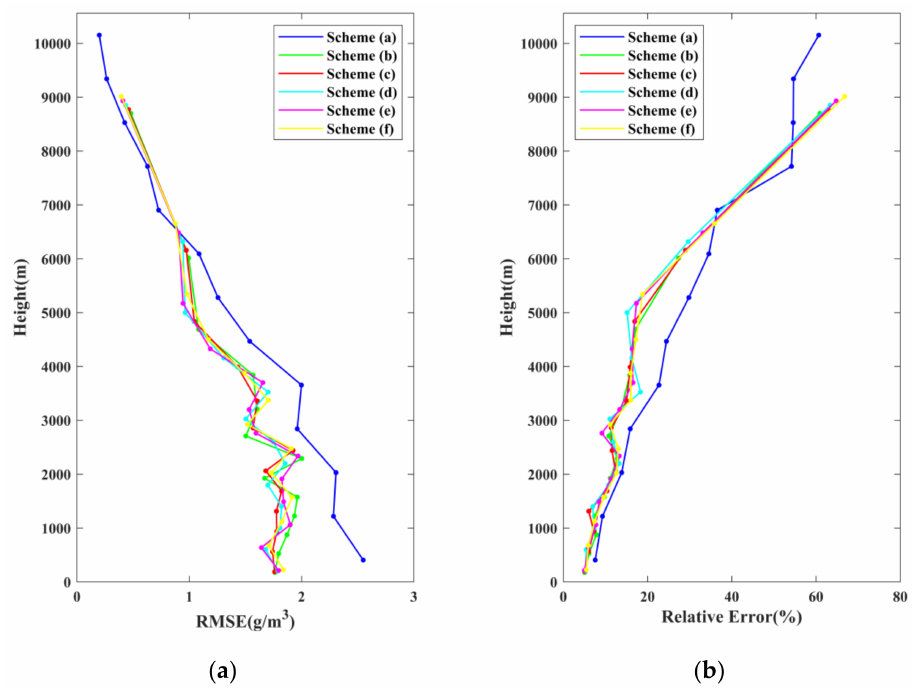
Figure 8. Comparison of the RMSE and relative error derived from six schemes in each stratification using radiosonde data as a reference (DOY 213 to DOY 243): ( a ) comparison of the RMSE in each stratification; ( b ) comparison of the relative error in each